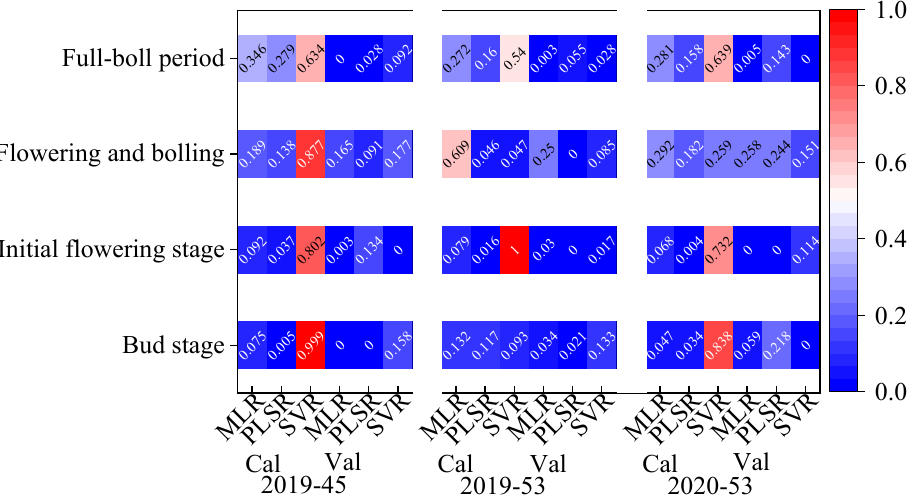
Figure 7. Estimation of model parameters of cotton leaf nitrogen concentration at different growth stages.